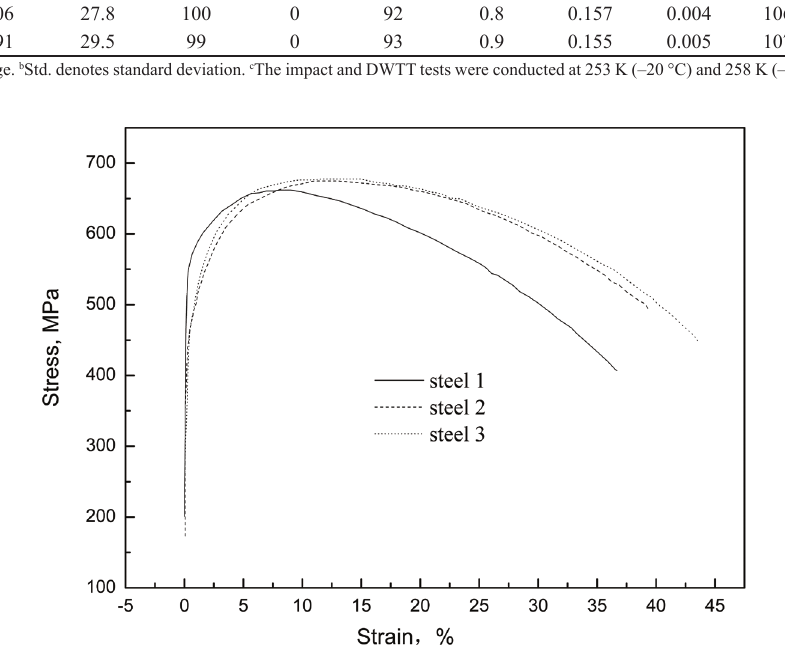
Figure 3. Stress-strain curves of experimental